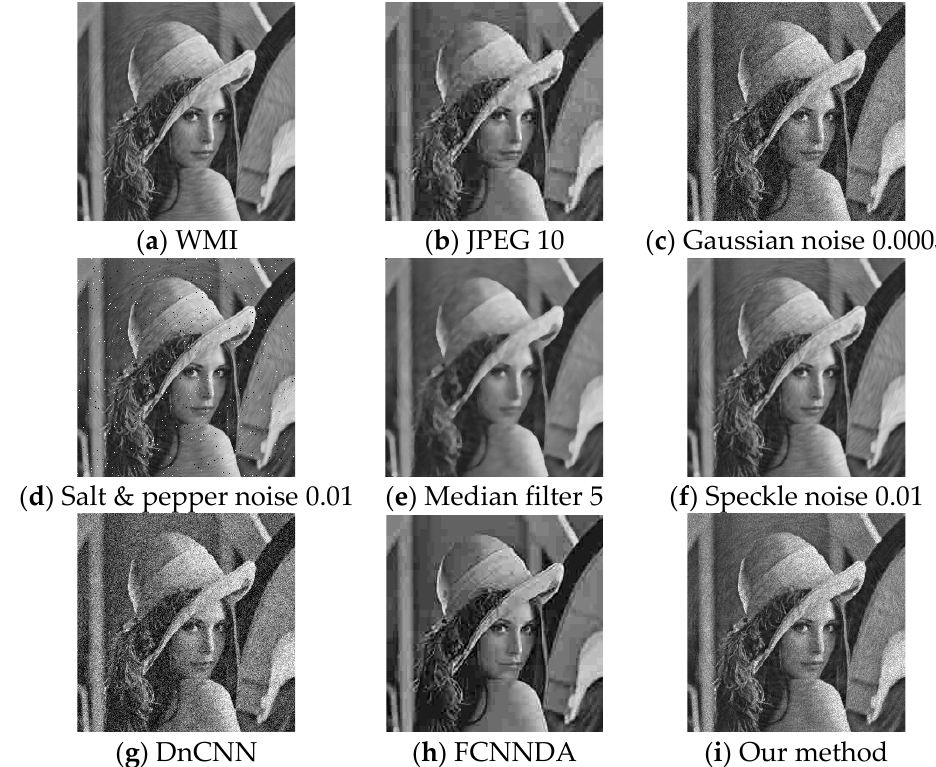
Figure 5. Comparison of AWMIs after applying different attacks to WMIs; the watermark size is 32 × 32.